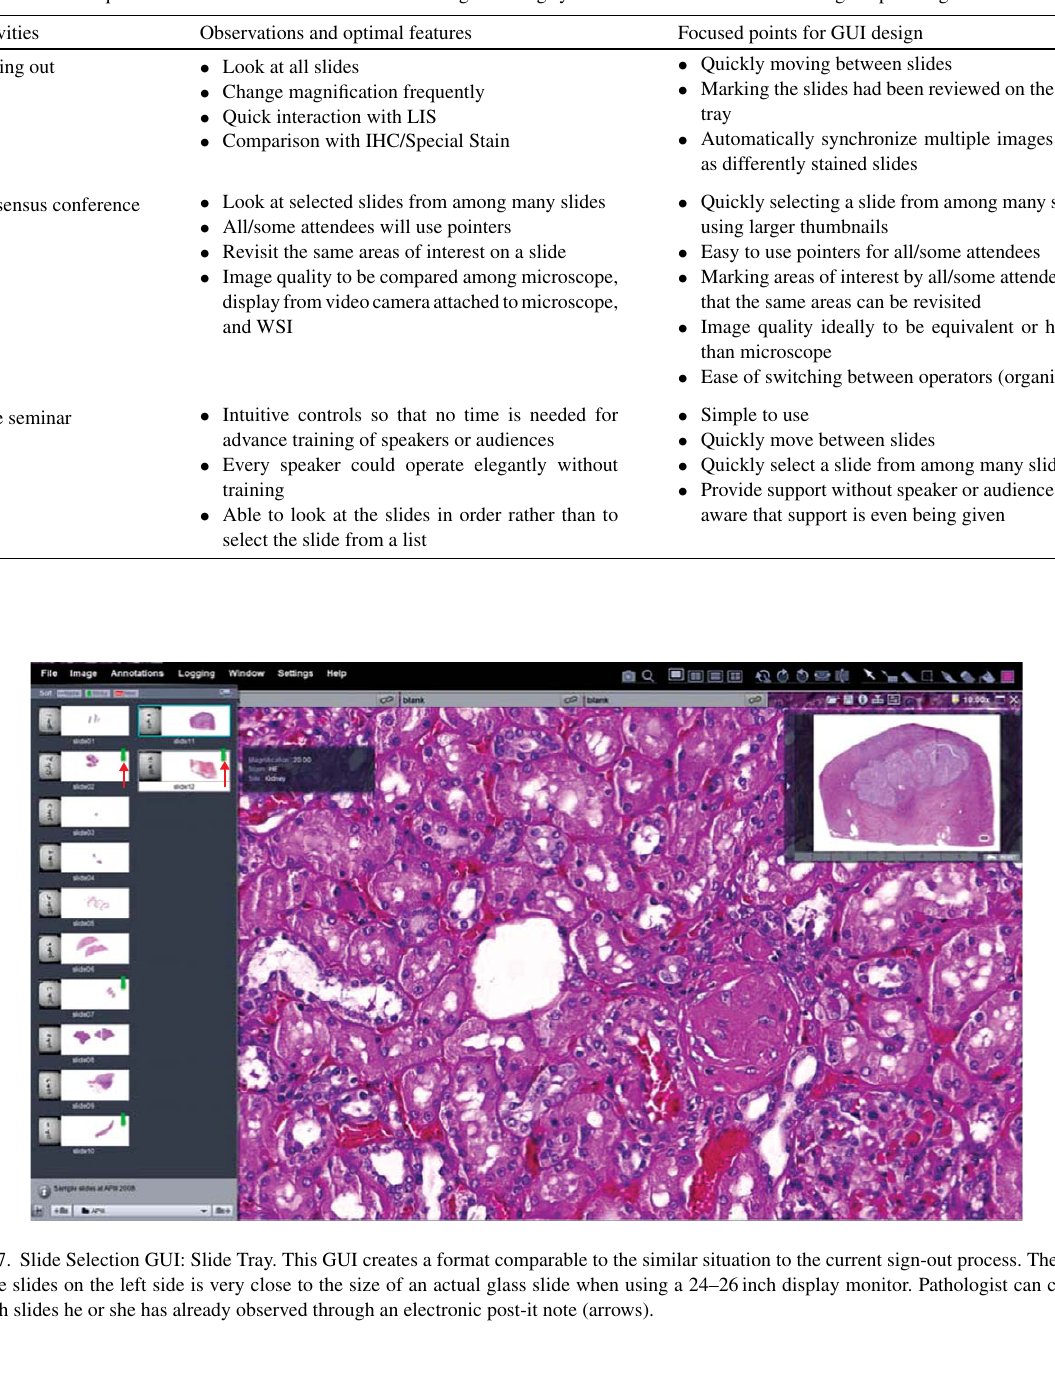
Requirements and solutions for whole slide image viewing systems in different activities of surgical pathologists